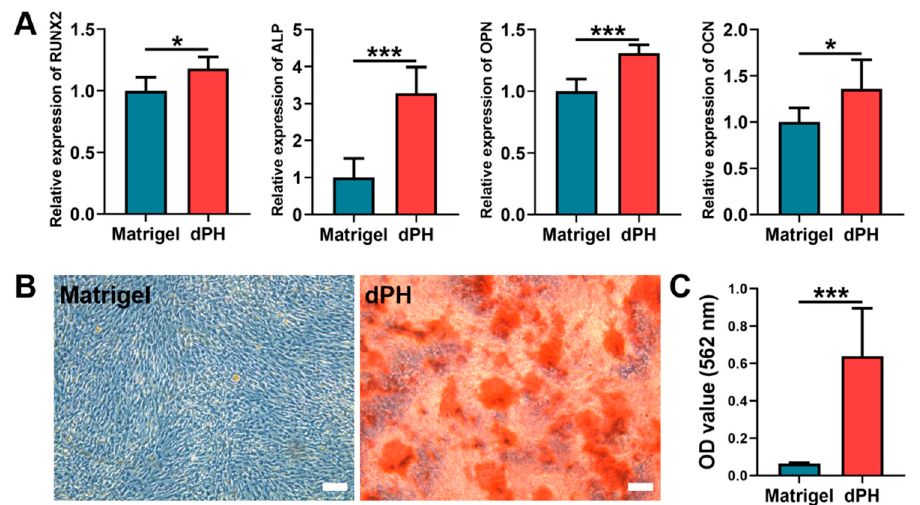
Figure 6. In-vitro osteogenic differentiation of hUCMSCs after being cultured on Matrigel and dPH for 14 days. ( A ) Expression levels of osteogenesis-related genes (RUNX2, ALP, OPN, and OCN). ( B ) ARS staining of the mineralized matrix formation of hUCMSCs cultured on Matrigel and dPH. ( C ) Quantitative analysis of ARS. Scale bar = 100 µ m. * p < 0.05, *** p <